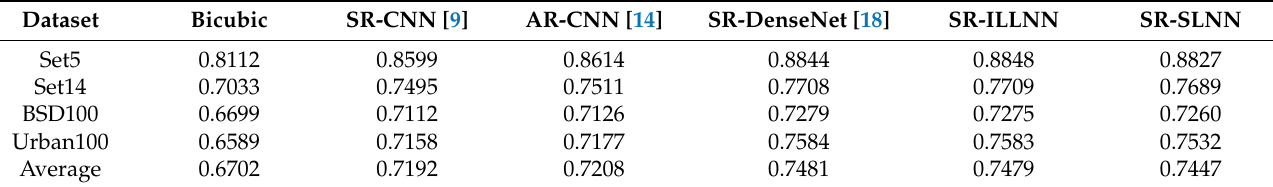
Table 7. Average results of SSIM on the test